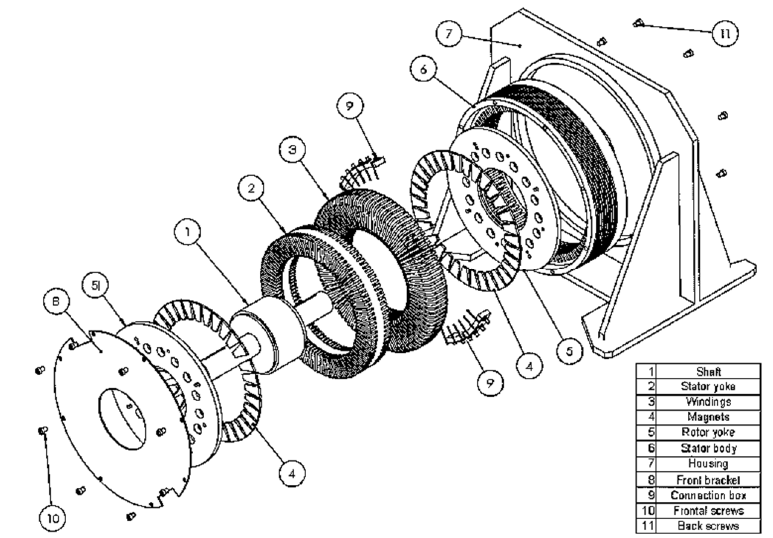
Figure A2. 6P-AFPMSM structure.